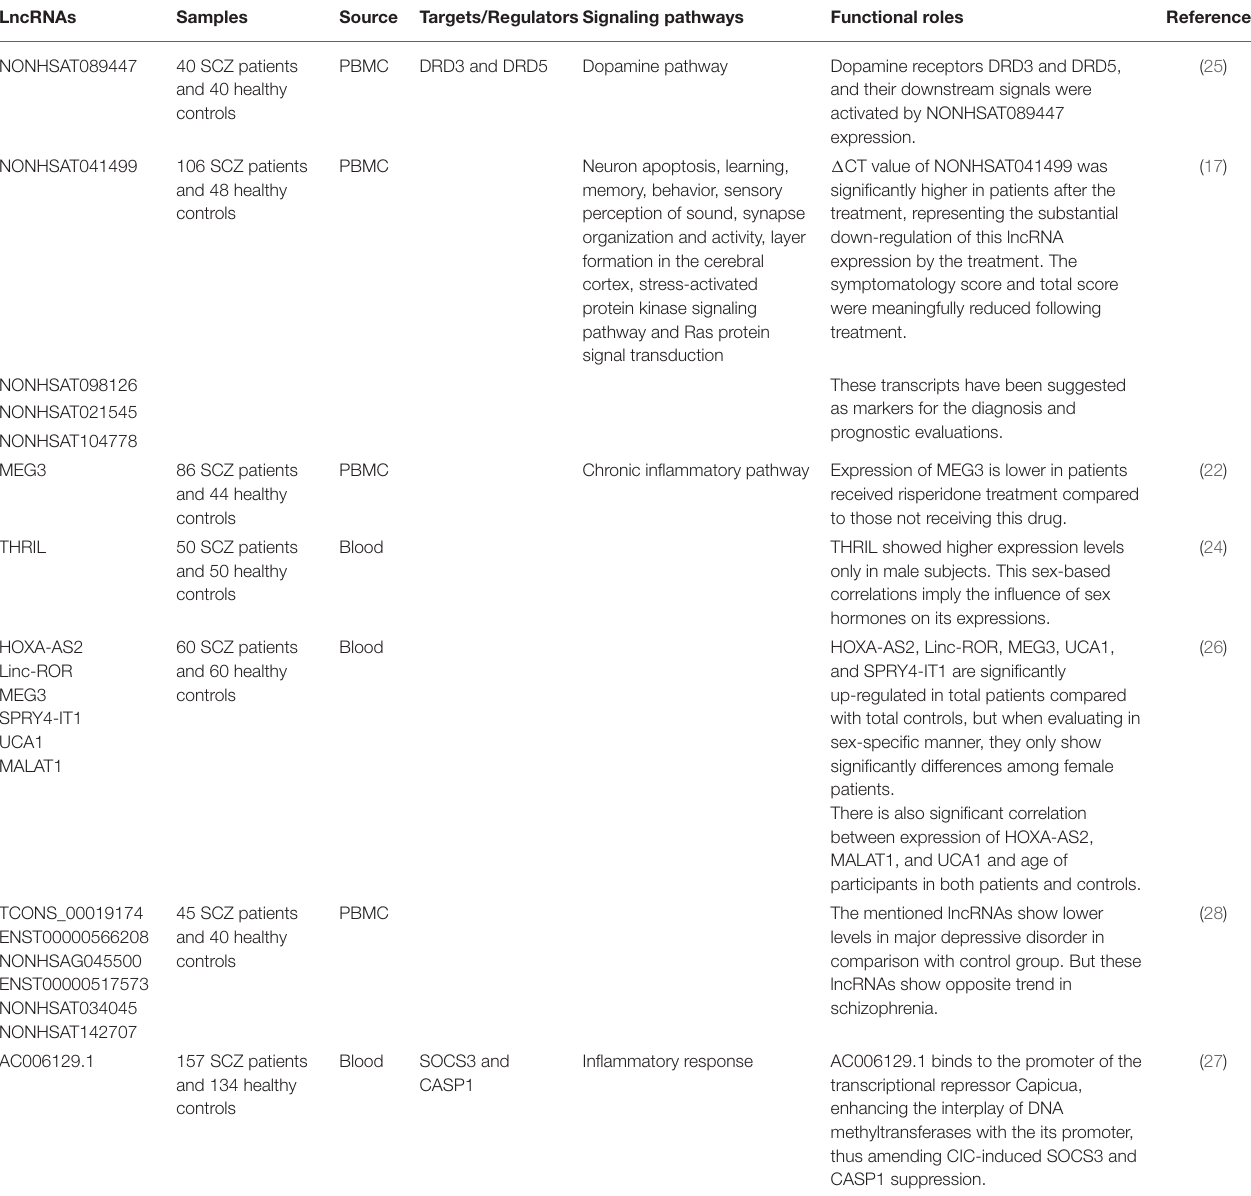
TABLE 2 | Up-regulated lncRNAs in schizophrenia (Empty cells show that this information has not been provided in the main